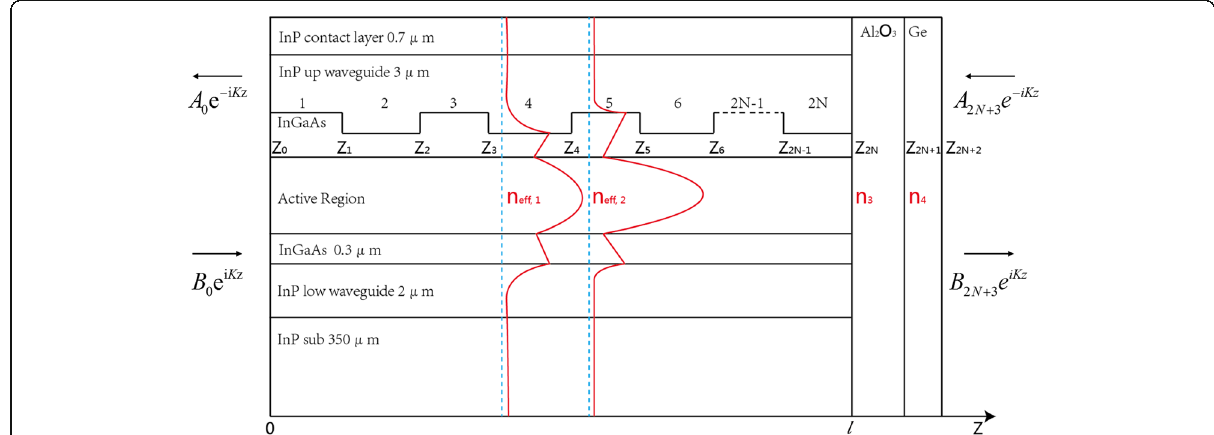
Fig. 1 Schematic illustrating the model of finite DFB cavity with antireflection coating on the longitudinal optical mode